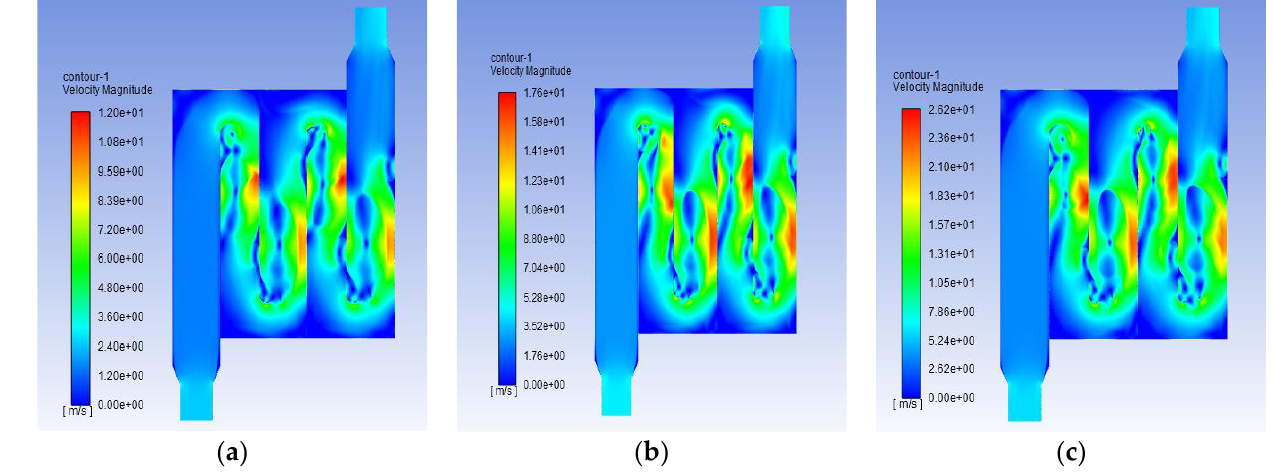
Figure 4. The velocity distributions corresponding to the different inlet flue gas velocities. ( a ) Velocity nephogram for v fg = 3 m · s − 1 . ( b ) Velocity nephogram for v fg = 5 m · s − 1 . ( c ) Velocity nephogram for v fg = 7 m · s − 1